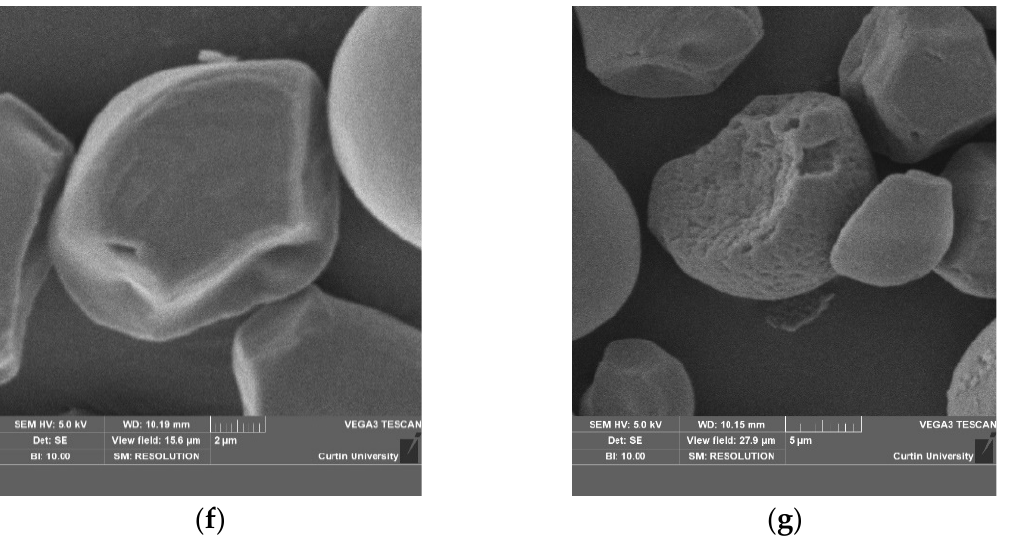
Figure 1. SEM images of tapioca starch granules: ( a ) native untreated, ( b ) treated with 0.4% alpha amylase, ( c ) treated with 0.6% alpha amylase, ( d ) ultrasonicated at 20 kHz, ( e ) ultrasonicated at 48 kHz, ( f ) combined 0.6% enzyme + 20 kHz ultrasonication, ( g ) combined 0.4% enzyme + 20 kHz ultrasonication. The red circle indicates the surface erosion of the granules.